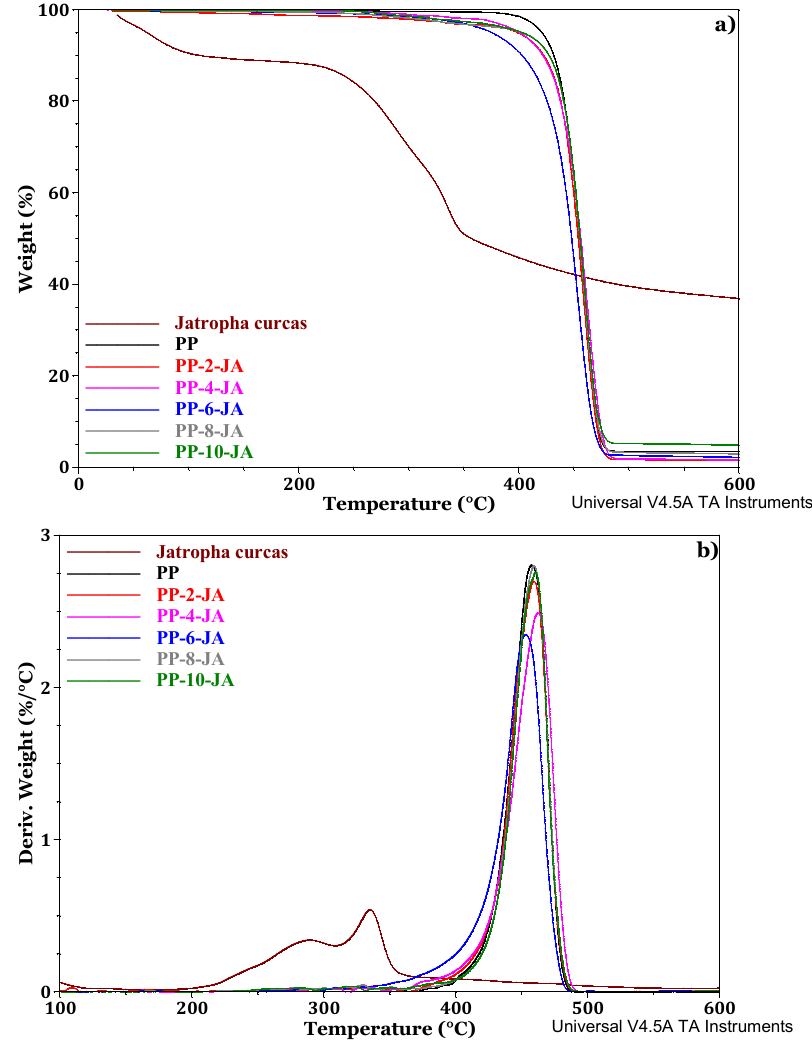
Figure 3. TGA thermogram of % weight loss ( a ) and derivative of %wt/ ◦ C ( b ) for PP, JA, and PP-JA composites.